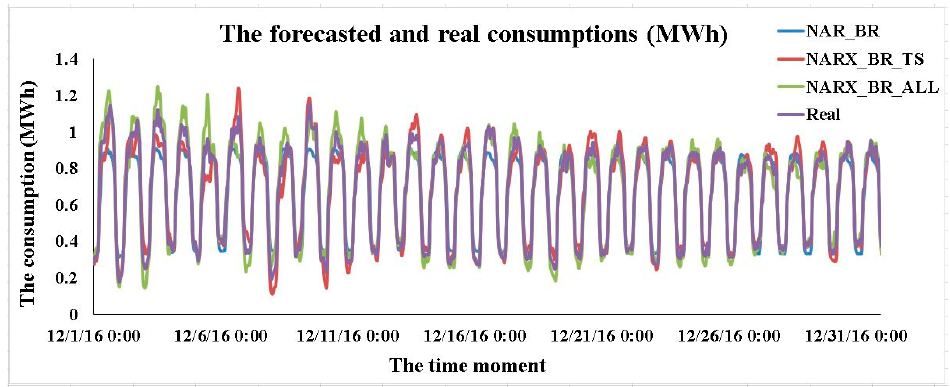
Figure 19. The real and forecasted consumptions.